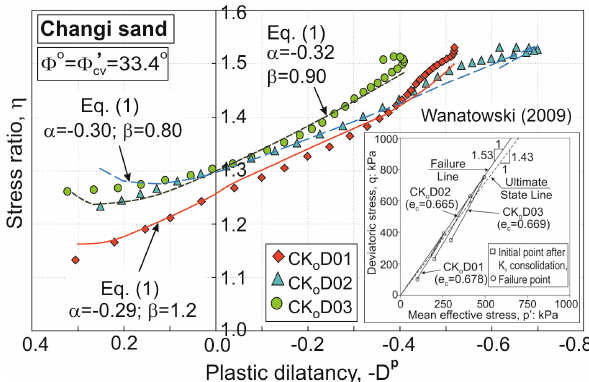
Fig. 7. Relationship between the stress ratio